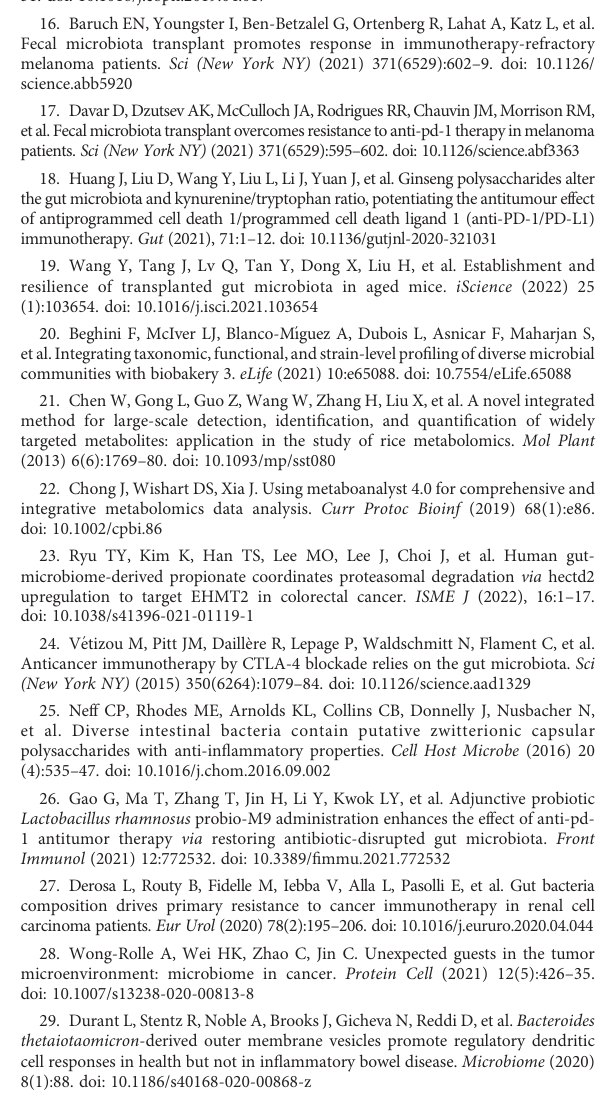
Differentially abundant blood metabolites of the CT26 tumor-bearing mice upon different types of treatment. p -adjusted value < 0.05 is considered as statistically signi fi